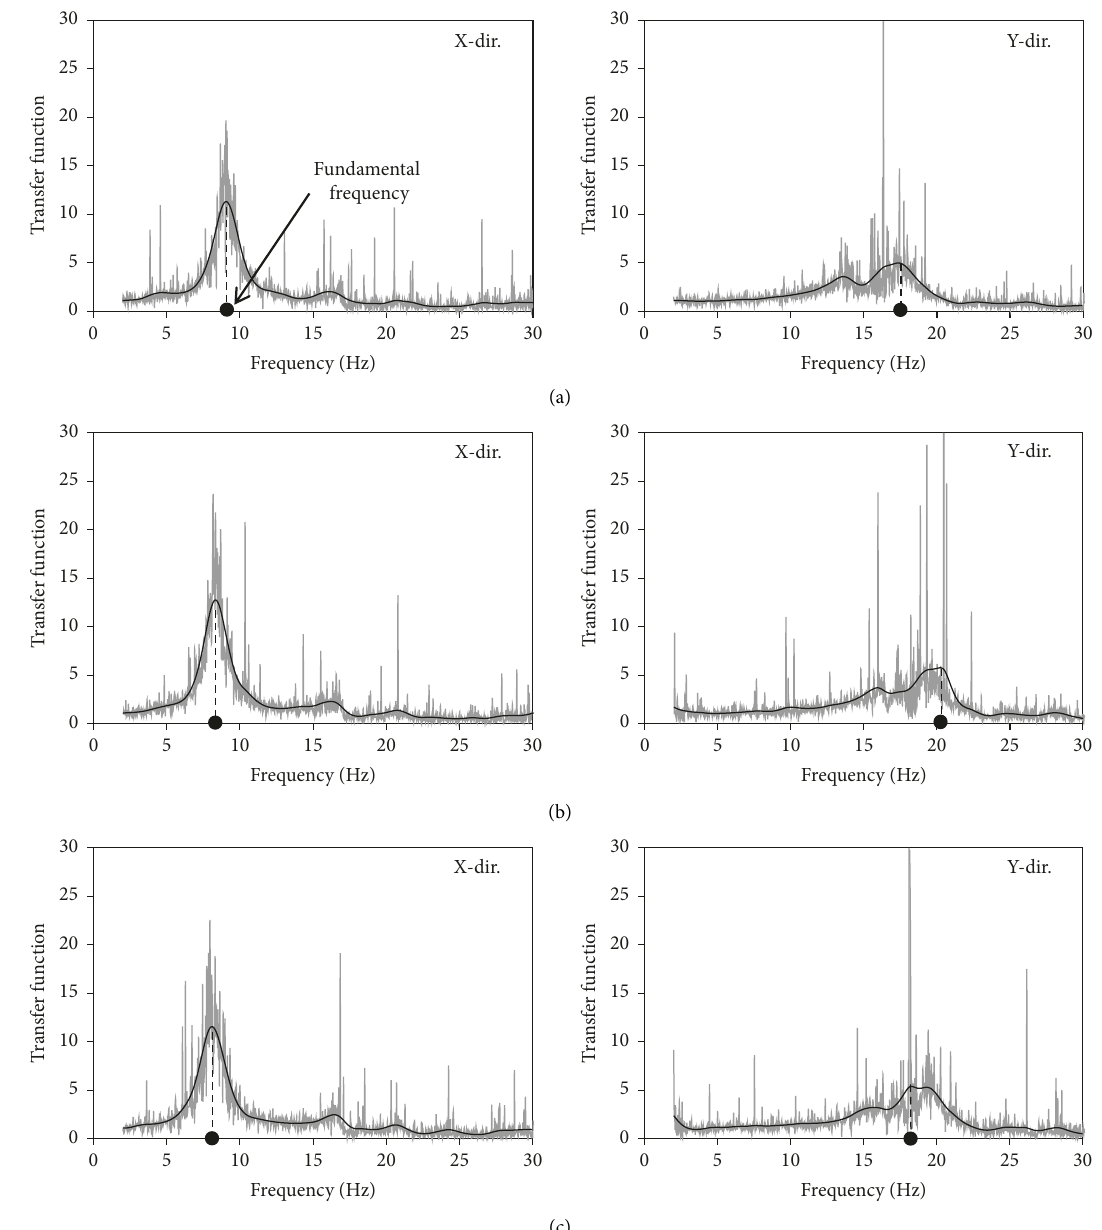
Figure 9: Transfer function-frequency curves at the top of the UPS specimens in Series A. (a) Test nos.1A–3A. (b) Test nos. 6A–8A. (c) Test nos.